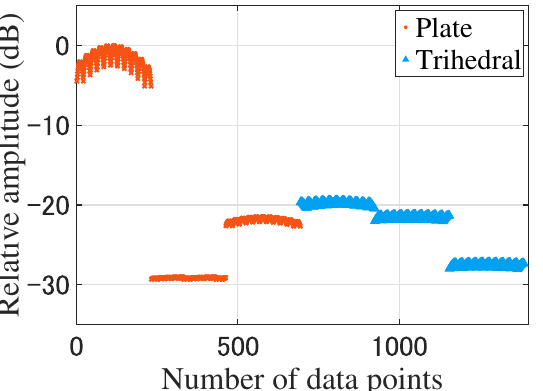
Figure 8. The characteristic distribution of the plane beam (the number of data is